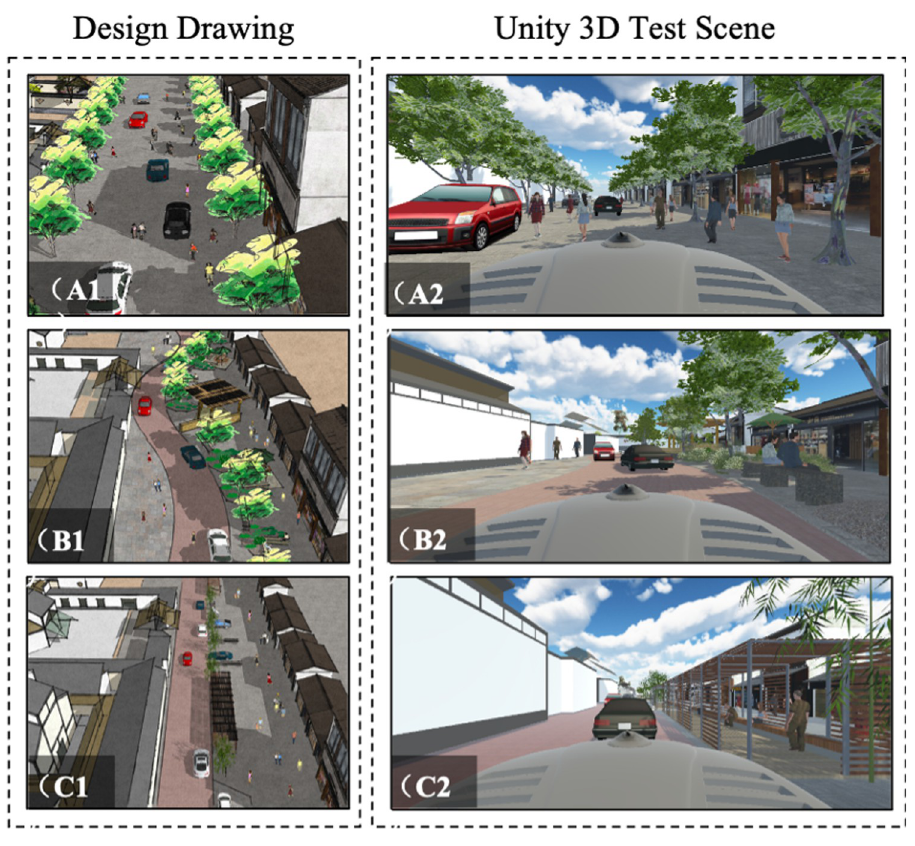
Fig 2. Scenarios